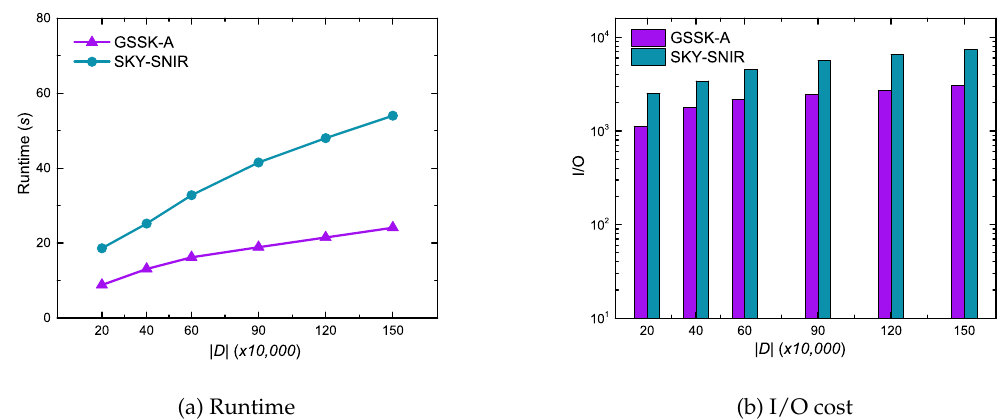
Figure 13. Effect of the number of data objects on runtime and I/O cost.